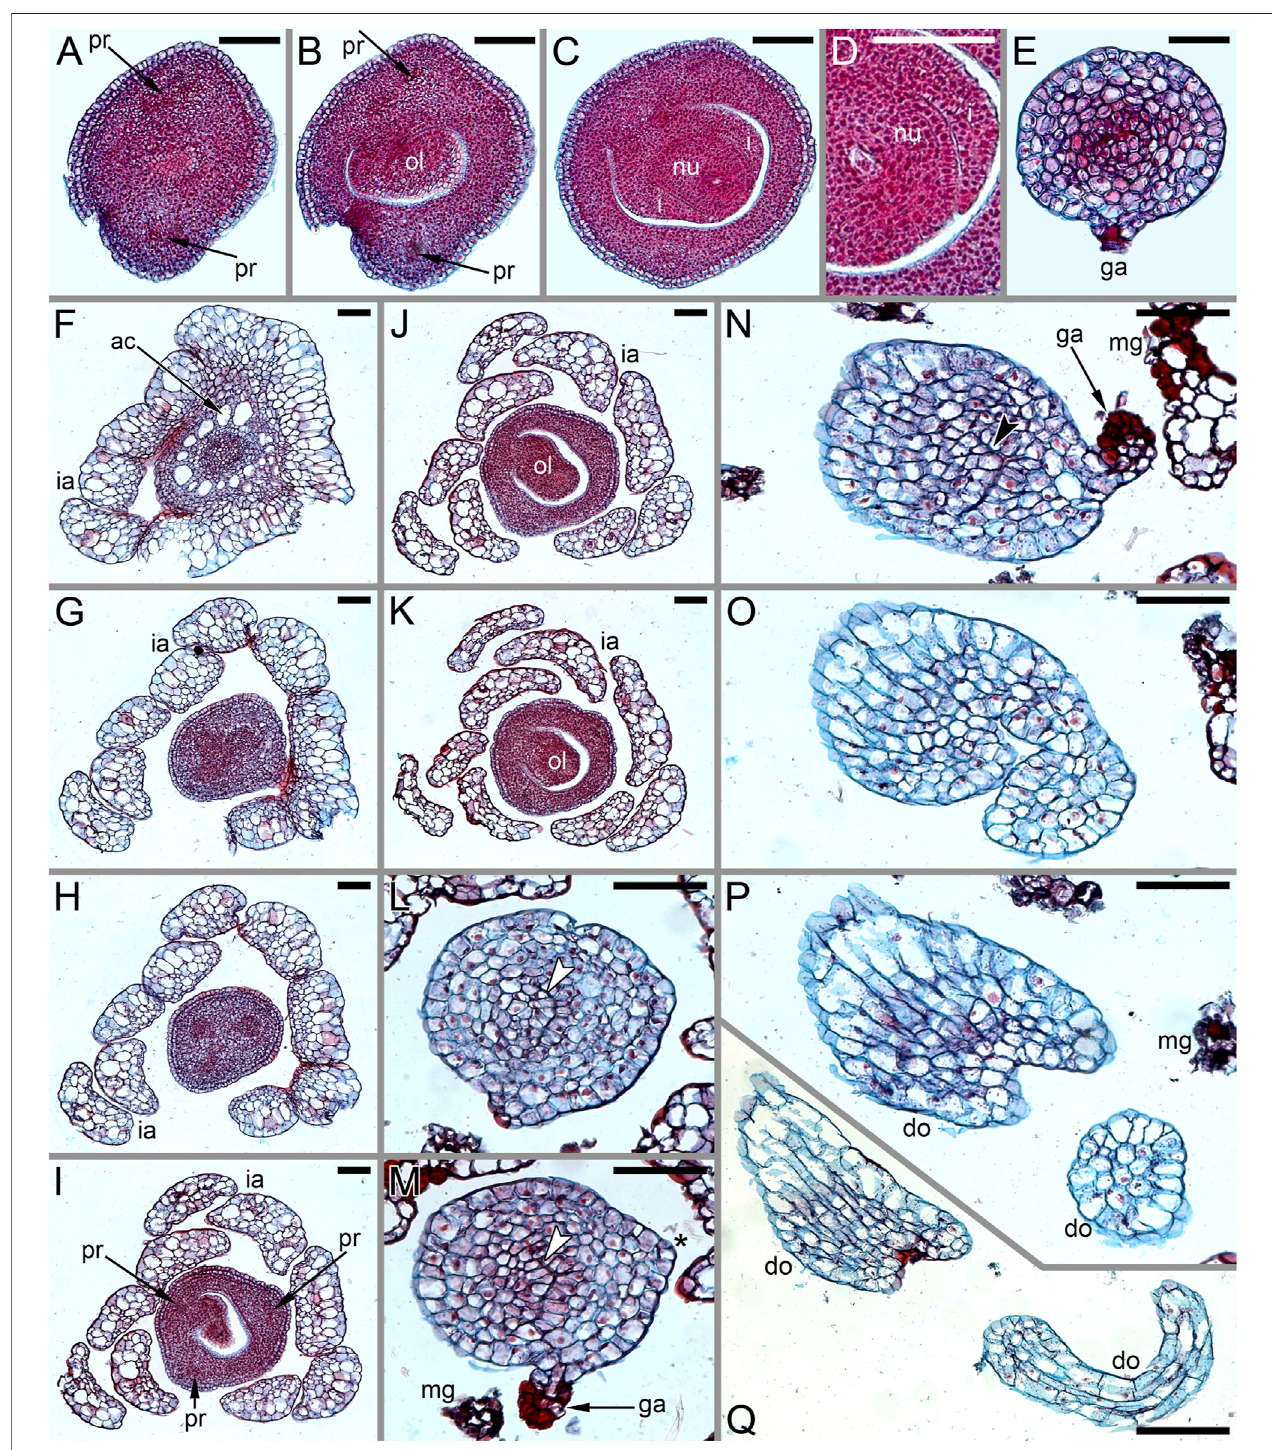
FIGURE 6 | Anatomyofpistillate fl owersof Ceratophyllumdemersum ,ascendingseriesoftransverseanatomicalsections(LM). (A – E) Flowerwithsingle,abaxialglandular gynoecial appendage and single horizontally directed ovule (involucral appendages not shown). Ovule insertion is nonmedian as evidenced by its position relative to the two procambial strandsand theglandular appendage. (A) Below the ovary locule. (B – D) Ovary loculeand ovule. (D) Detailofsection justabove (C) ; notethe clearly visibleboundary betweenthenucellusandtheintegument. (E) Levelofglandularappendage. (F – Q) Flowerwithtwoglandulargynoecialappendagesandasinglehorizontallydirectedovule. (F) Levelofattachmentofinvolucralappendages. (G) Trilobed bundleinthegynoeciumstalk. (H) Threedistinctbundlesinthegynoeciumstalk. (I – K) Theovuleisattachedalong almosttheentirelengthoftheovarylocule. (L – N) Sectionsbetweentheovaryloculeandthegynoecialori fi ce(arrowheads,stylarcanal). (M,N) Sectionsshowingthetwoglandular appendages. Each of these two sections shows only one glandular appendage, but these are two different appendages. Asterisk in (M) indicates the radius of the appendage visible in (N). (O) Gynoecium ori fi ce. (P, Q) Distal outgrowths of the gynoecium. Scale bars = 100 μ m in (A – Q) .